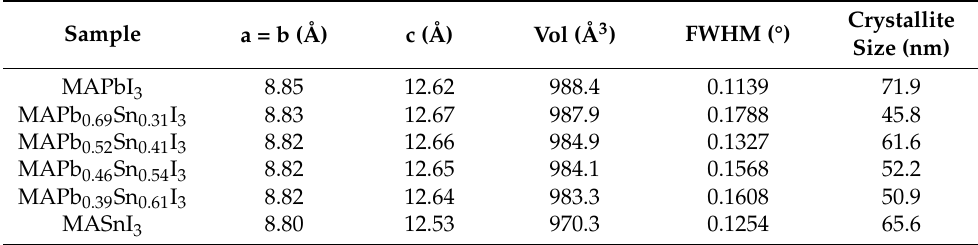
Table 2. Lattice constants, FWHM of (110) peak and crystallite size of perovskite films.